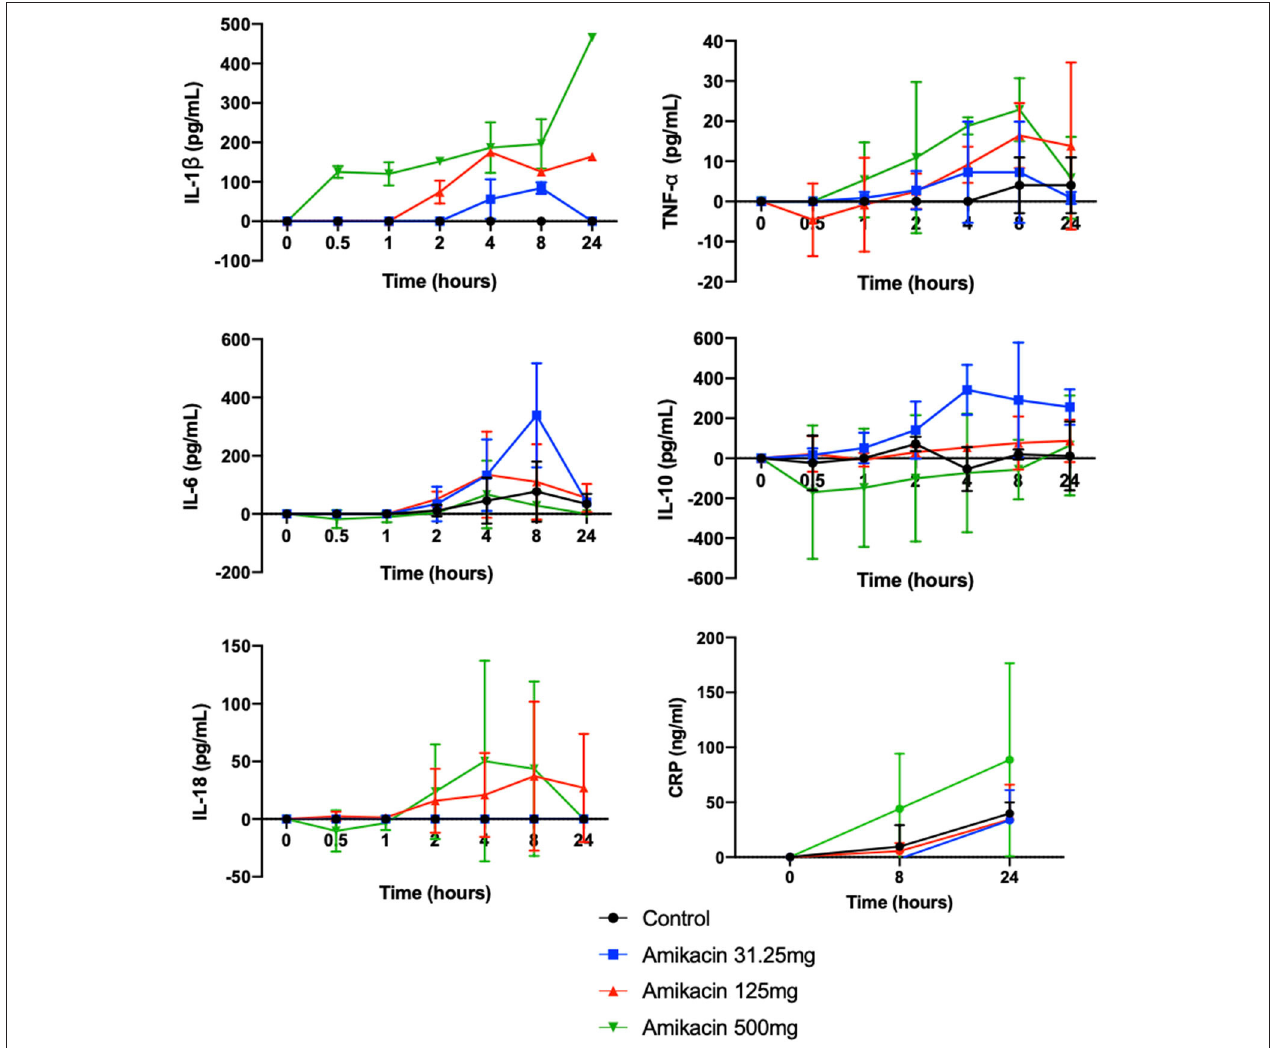
FIGURE 4 | Concentrations of the biomarkers of inflammation in synovial fluid of joints injected with amikacin, normalized to baseline. The concentrations of 23 analytes (eotaxin/CCL11, FGF-2, fractalkine/CS3CL1, G-CSF, GM-CSF, GRO, IFN, IL-1 α , IL-1 β , IL-2, IL-4, IL-5, IL-6, IL-8/CXCL8, IL-10, IL-12 (p70), IL-13, IL-17a, IL-18, IP-10, MCP-1, RANTES/CCL5, and TNF α ) were quantified in synovial fluid samples from all treatment groups at all time points using fluorescent bead-based multiplex assay. Measurable cytokine levels were detectable for 10 of 23 cytokines (IL1 β , FGF, G-CSF, IL-10, TNF α , IL-6, IL-8, IL-18, IP-10, or MCP-1). The cytokine levels were compared between treatment groups at each time point and between time points for each treatment group, as well as for the overall effect of treatment and time by two-way analysis of variance. Significant differences were seen across time points for IL1- β for control vs. 125mg amikacin ( p < 0.0008) and control vs. 500mg ( p < 0.0001), TNF- α for control vs. 500mg ( p = 0.0281), and IL-10 for control vs. 31.25mg amikacin ( p = 0.0066). Five cytokines (IL1 β , FGF, G-CSF, IL-10, and TNF α ) additionally had significantly different levels between time points for each treatment group evaluated or between treatment groups at different time points. No significant differences between treatment groups were observed in the levels of IL-6, IL-8, IL-18, IP-10, or MCP-1. An ELISA was also used to determine the concentrations of inflammatory C-reactive protein (CRP) in the synovial fluid. Three joints were included per treatment group. The cytokine levels were compared between three treatment groups using a two-way ANOVA. Results are expressed as the mean ± SD, normalized to baseline.